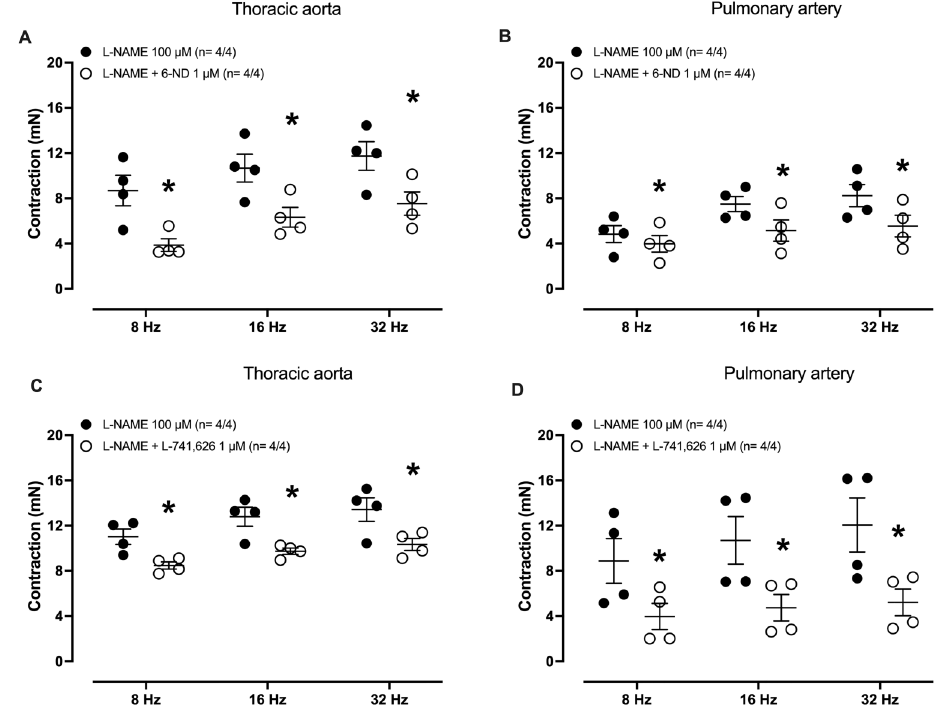
Figure 5. Effect of 6-nitrodopamine (6-ND) and L-741,626 on electric- fi eld stimulation (EFS)-induced contractions in thoracic aorta and pulmonary artery rings. Endothelium-intact aorta and pulmonary artery rings were pre-treated with L-NAME (100 m M, 30 min), after which were incubated or not with either 6-ND (1 m M, n= 4/4; Panels A and B ) or the selective dopamine D 2 -receptor antagonist L-741,626 (1 m M, n= 4/4; Panels C and D ). EFS at 8 to 32 Hz was then applied to both tissues. The number of experiments (n) is reported as x/y, where x represents the number of animals and y the number of rings employed. Data are reported as means ± SE. *P o 0.05 (Student ’ s unpaired t